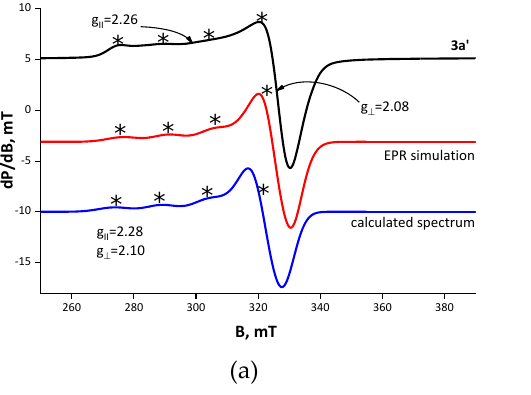
Figure 4. EPR spectra (in black) of the powder green complexes ( a ) 3a’ and ( b ) 3b’ , 100 K. The simulated EPR spectrum (in red) and the DFT computed spectrum (in blue) are also presented. With asterisk * are labeled the lines of the hyperfine Cu 2+ structure. Table 3. X-band EPR parameters of copper(II) complexes 2a’ – b’ and 3a’ – b’ and copper(II) salts.